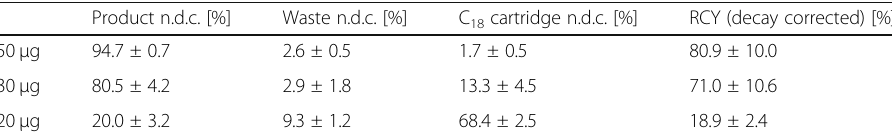
Table 1 Activity measured on different parts of the cassette immediately after synthesis ( n ≥ 3) Product n.d.c.